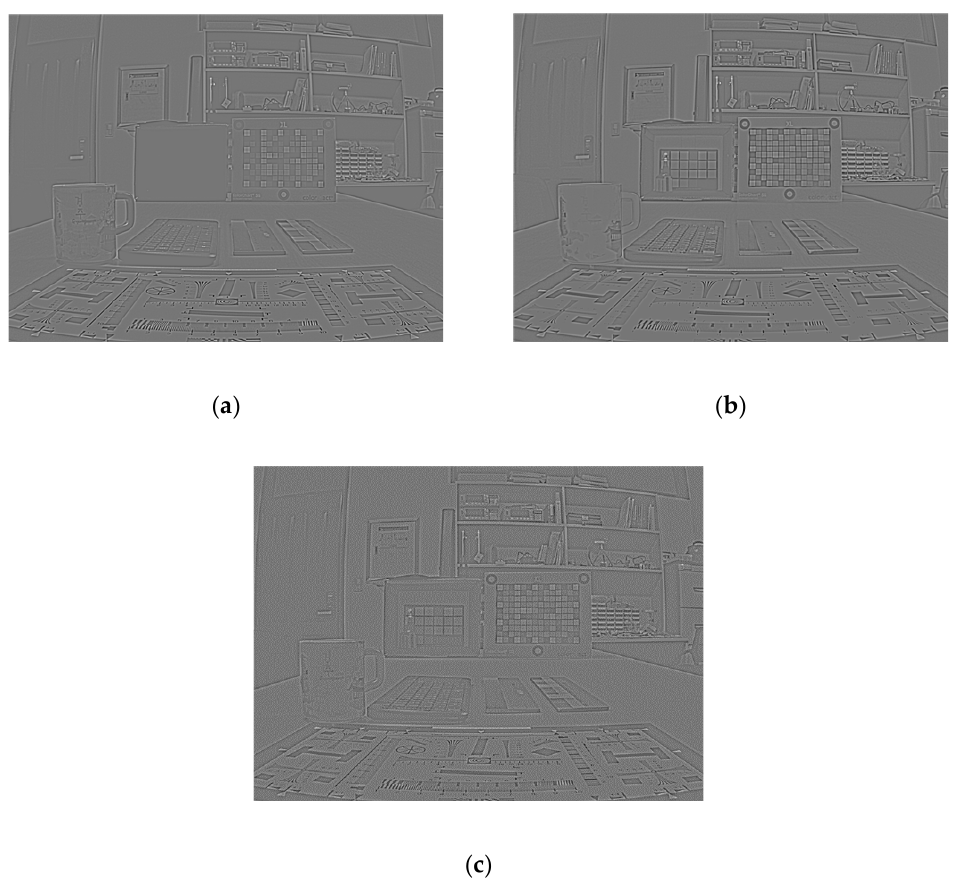
Figure 10. Result of detail layer synthesis: ( a ) visible-light image detail layer, ( b ) near-infrared image detail layer, ( c ) detail layer synthesis result.